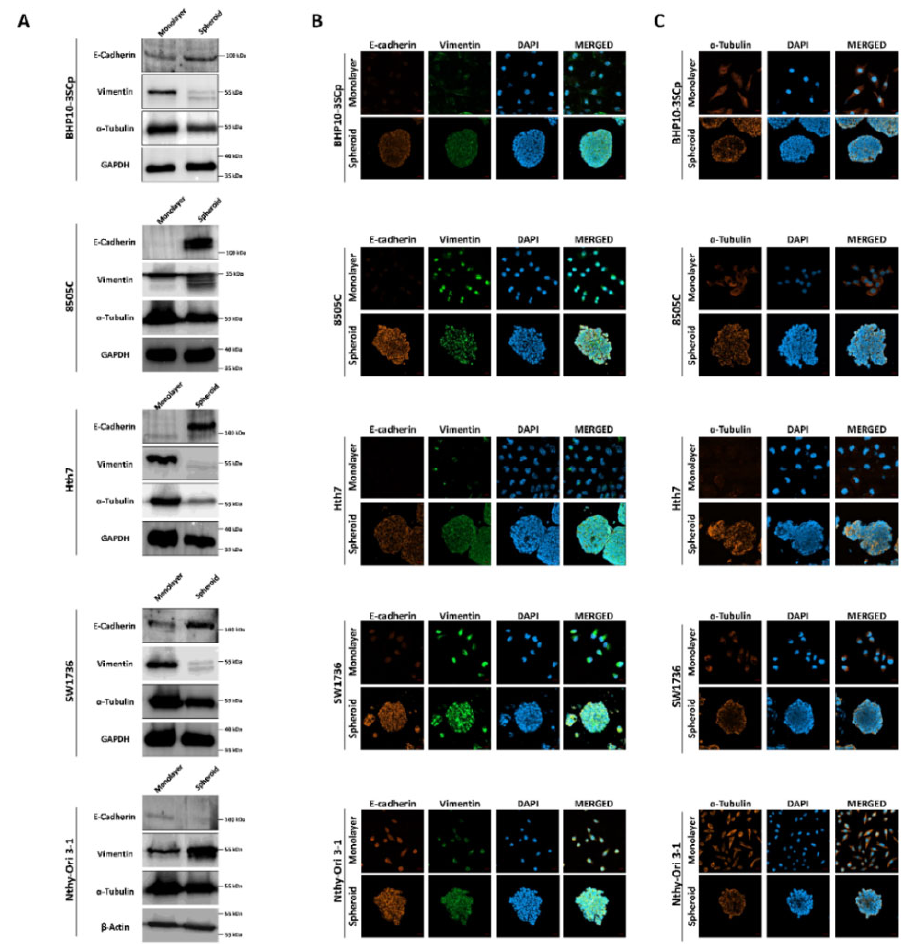
Figure 6. Observation of the extracellular matrix (ECM) and the cytoskeleton under the 2D monolayer and 3D spheroid conditions. E-cadherin and vimentin were used as ECM markers. α -tubulin was used as a cytoskeleton marker. ( A ) Western blot analysis showed E-cadherin, vimentin, and α -tubulin expression. GAPDH and β -Actin were used as loading control. Representative immunofluorescence images showing ( B ) ECM and ( C ) cytoskeleton. Scale bar: 50 μ m.